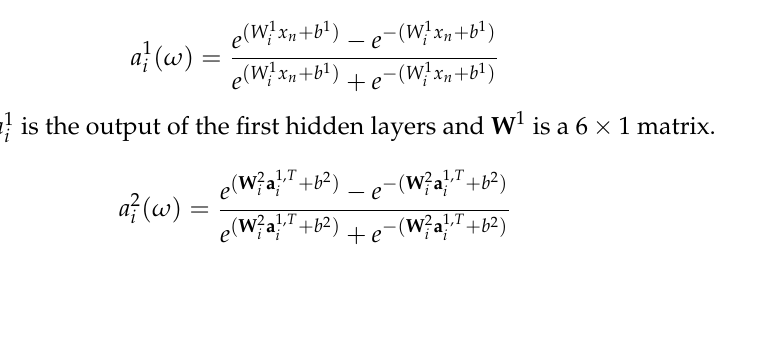
Figure 1. The three-layer DNN structure with six and three nodes in two hidden layers,